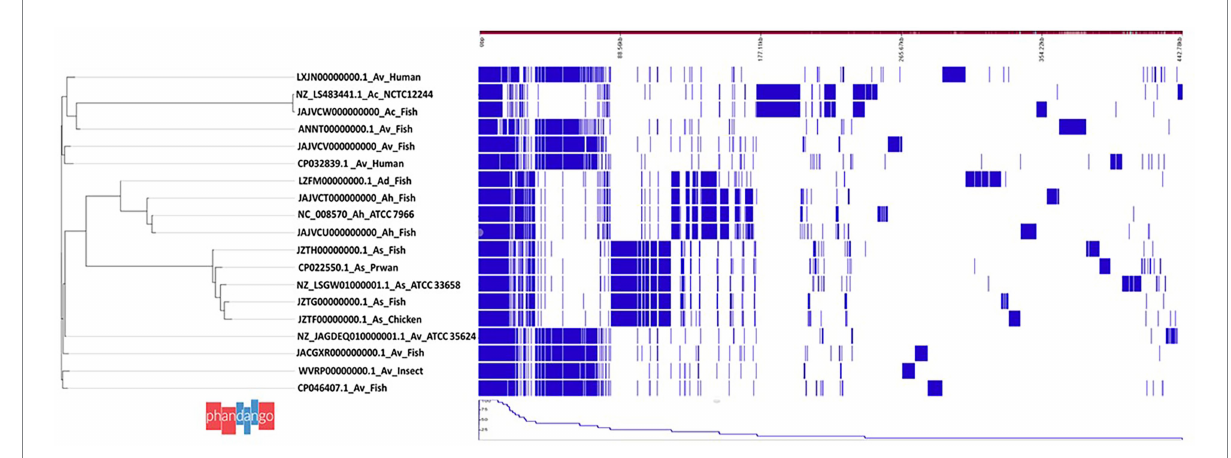
FIGURE 1 Pangenome analysis of 15 Aeromonas spp. isolated from different host species in India. Note that the 15 Aeromonas spp. are in four groups based on species. (i) Group comprises of Aeromonas veronii isolates and reference strain NZ_LS4883441.1 NCTC12244, (ii) Group 2 consists of a A. hydrophila and A. veronii isolate and reference strain NC_008570 Ah_ATCC7966, (iii) Group 3 consists of A. salmonicida isolates and reference strain NZ_LSGW01000001.1_As_ATCC33658, and (iv) Group 4 consists of A. hydrophila and A. dhakensis isolates together with the NZ_ JAGDE01000001.1 Av_ATCC35624 reference